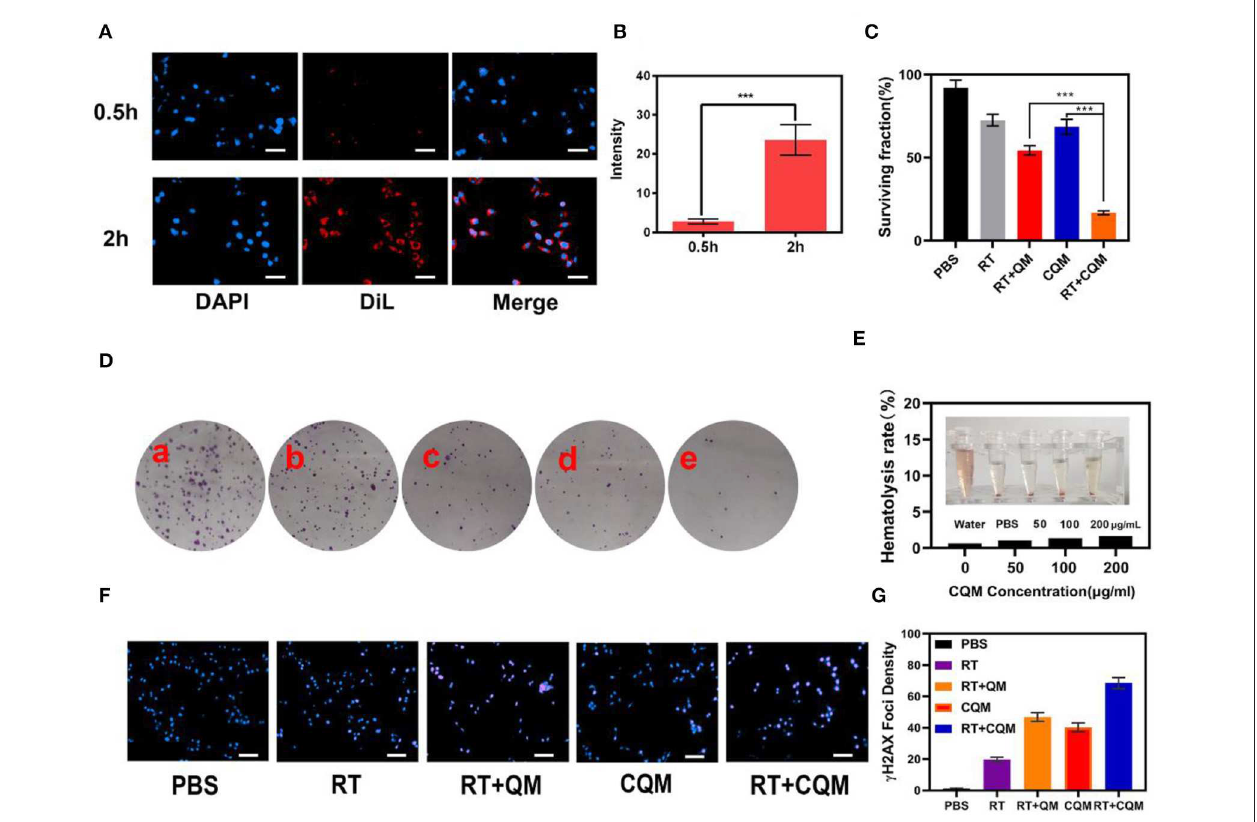
FIGURE 2 | Results of in vitro experiments. (A) Fluorescence images of 4T1 cells after treatment with CQM across time. Scale bars: 50 µ m. (B) DiL fluorescence intensity of (A) measured using imageJ software. (C) Clonogenic 4T1 cell rate of survival when co-incubated with different formulations for 12h prior to receiving RT or not. Colonies with > 50 cells were counted. (D) 4T1 cells treated with (a) PBS, (b) RT, (c) CQM, (d) RT + QM, or (e) RT + CQM. The MSN concentration was 200 µ g/mL and the irradiation dose was 4Gy. (E) Hemolysis ratio of QM at different CQM concentrations. The inset presents the corresponding hemolysis images. (F) Representative fluorescence images of DNA fragmentation and nuclear condensation after different treatments. DAPI and γ -H2AX were used for nuclear visualization and DNA fragmentation, respectively. Scale bars: 50 µ m. (G) Quantitative analysis of γ -H2AX foci density ( γ -H2AX foci/100 µ m − 2 ) for n > 100 cells in each treatment group. Significant differences among groups as calculated using the Student’s t -test. *** P <